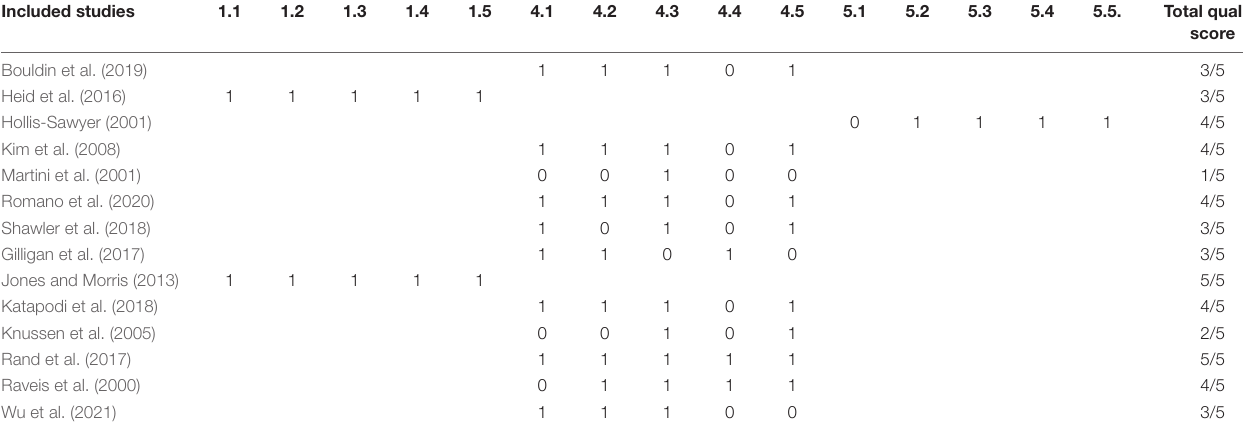
TABLE 2 | Criteria from the Mixed Methods Appraisal